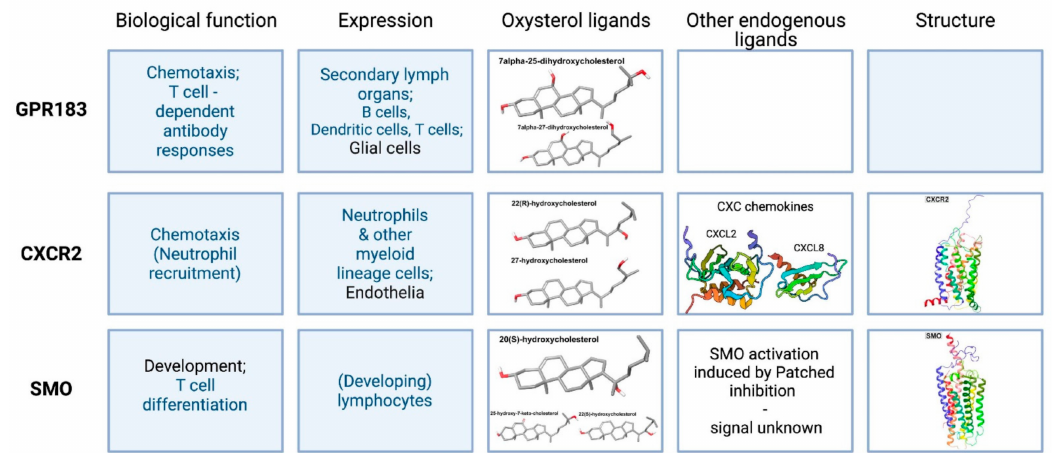
Figure 1. Overview of the biological functions and distribution (Expression)s of oxysterol activated GPCRs in cells of the immune system. The structures of their endogenous oxysterol ligands, details of other endogenous ligands and, where available, models of their three-dimensional structures of these receptors are also shown. This image was created using BioRender